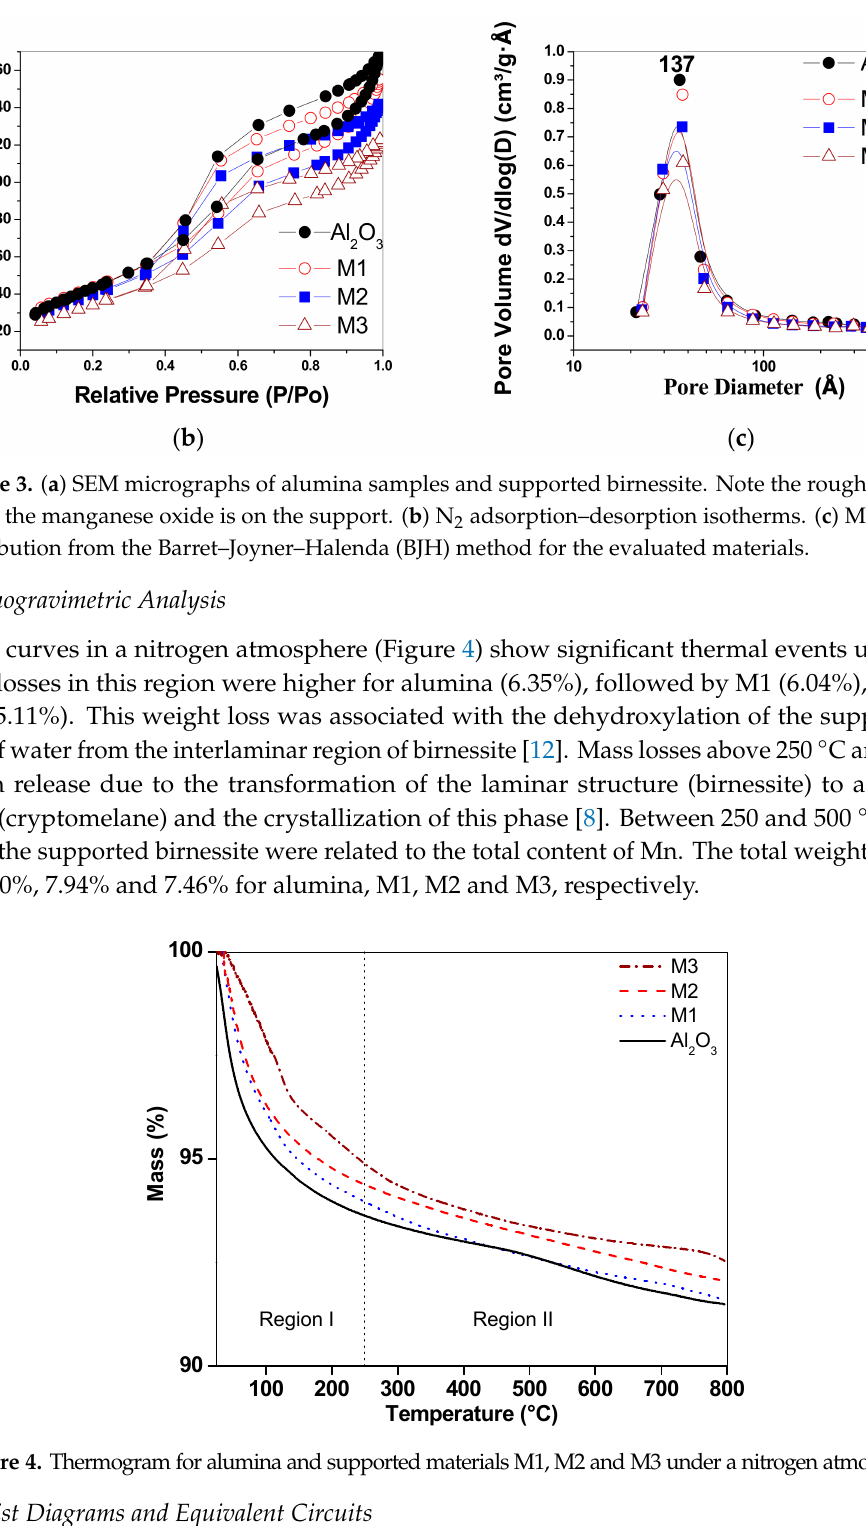
Figure 3. ( a ) SEM micrographs of alumina samples and supported birnessite. Note the rough surface